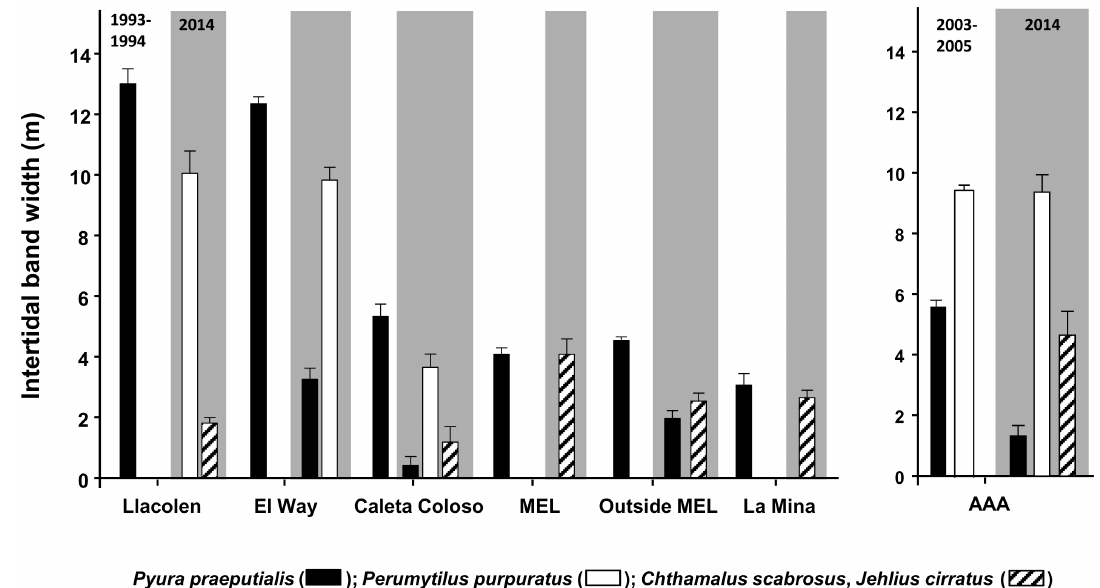
Figure 3. Mean intertidal band width (m; SE) of the tunicate Pyurapraeputialis (black bars), the mussel Perumytiluspurpuratus (white bars) and barnacles ( Chthamalusscabrosus , Jehliuscirratus ) (striped bars) at 7 sites in the bay of Antofagasta. For the first 6 sites the comparison is between 1993–1994 and 2014. For the seventh site the comparison is between 2003 and 2014 (b).